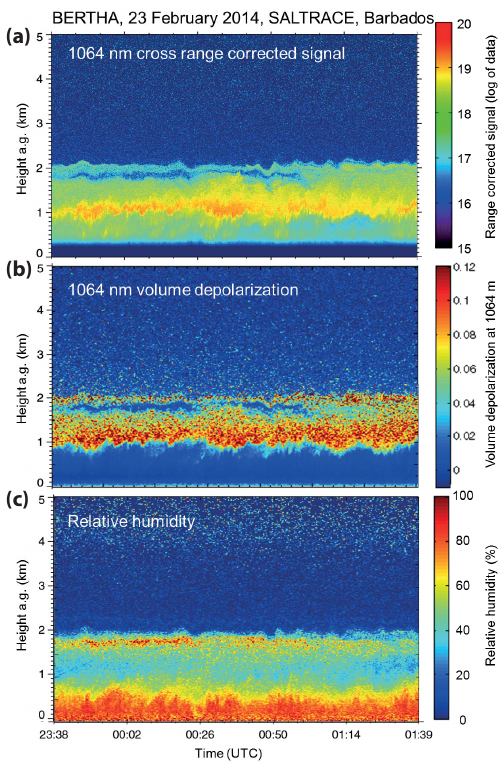
Figure 4. Marine aerosol layer (MAL) over Barbados on 23 Febru- ary 2014, 19:38–21:39 local time, with the cloud-free MBL reach- ing to 0.8–1km height (indicated by a low depolarization ratio and high RH) and an extended layer between about 1 and 2.1km height with dried marine sea salt particles causing enhanced light depolar- ization ( b yellow–red areas) at low RH of < 50% ( c , bluish areas). The cross-polarized 1064nm signal ( a 10s temporal, 7.5m verti- cal resolution) highlights the layer with dried marine particles (yel- low areas). Panels (b) and (c) are based on depolarization ratio and RH profile values averaged over 30s and vertically smoothed over 22m (b) and 52m (c)